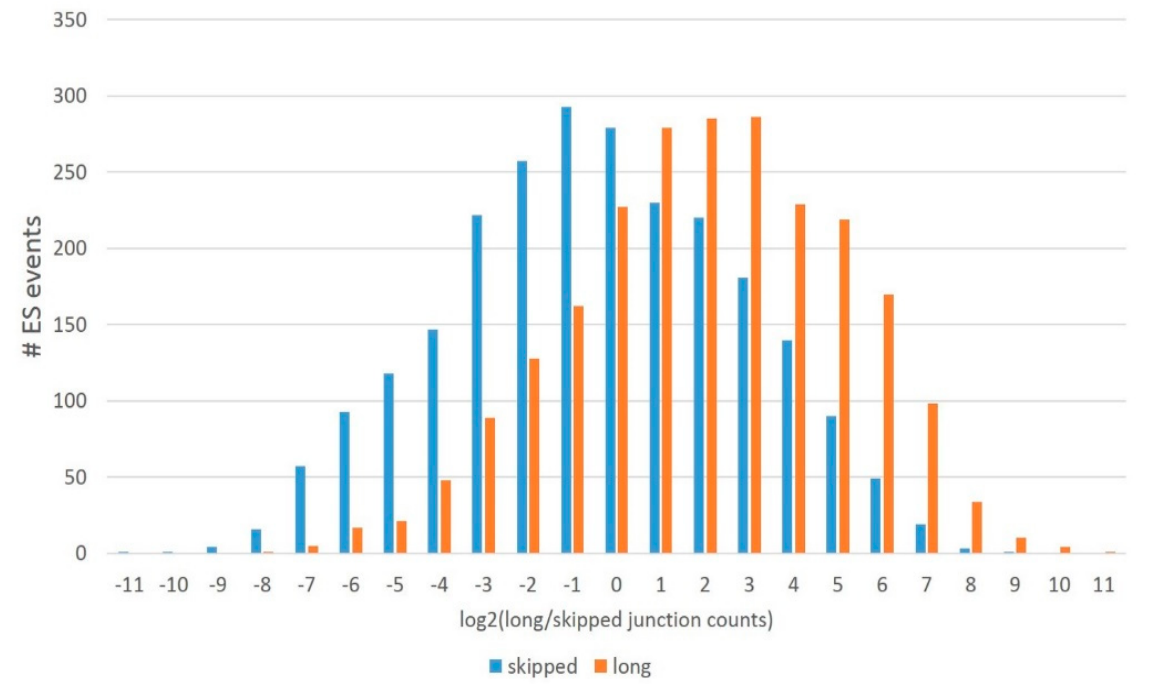
Figure 17. Distribution of the expression log ratio of long/skipped coding isoforms based on junction counts (abscissa): 0 corresponds to long and skipped isoforms equally expressed; positive numbers signify preferential long isoform expression; and negative numbers point to skipped isoform preference. Table 5. Distribution of the top ES events across gene families sorted in descending order of the number of ES fields. Statistically significant DAS FDR for a particular gene from the family (if any) is boldfaced.